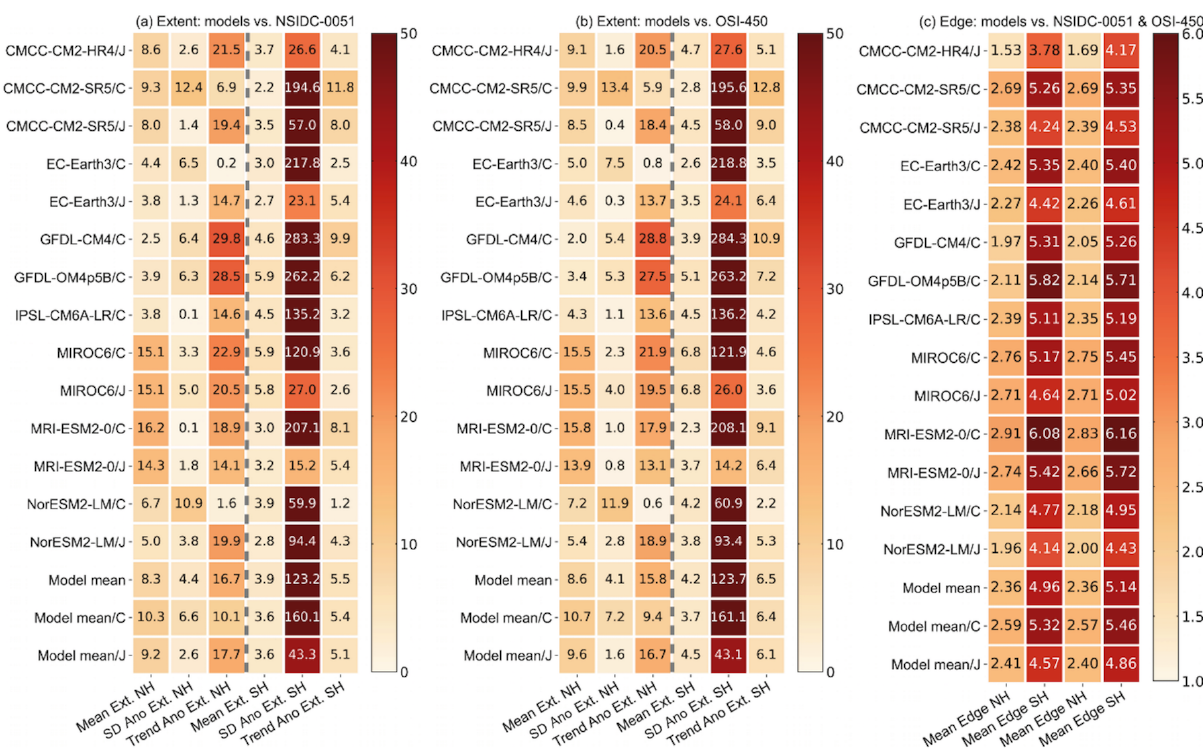
Figure 5. The ice extent metrics of 14 model outputs under OMIP1 (/C) and OMIP2 (/J) protocols, 14-model mean (model mean), five- OMIP1-model mean (model mean/C) and five-OMIP2-model mean (model mean/J) from CMCC-CM2-SR5, EC-Earth3, MIROC6, MRI- ESM2-0, and NorESM2-LM compared to (a) NSIDC-0051 and (b) OSI-450 data. The six columns correspond to model performance metrics on the mean state, standard deviation (SD Ano), and trend (Trend Ano) of monthly anomalies of the Arctic and Antarctic ice extent during 1980–2007. (c) The mean state ice-edge location metrics during 1980–2007 in both hemispheres compared to the NSIDC-0051 (first two columns) and OSI-450 data (last two columns). Lower values indicate better